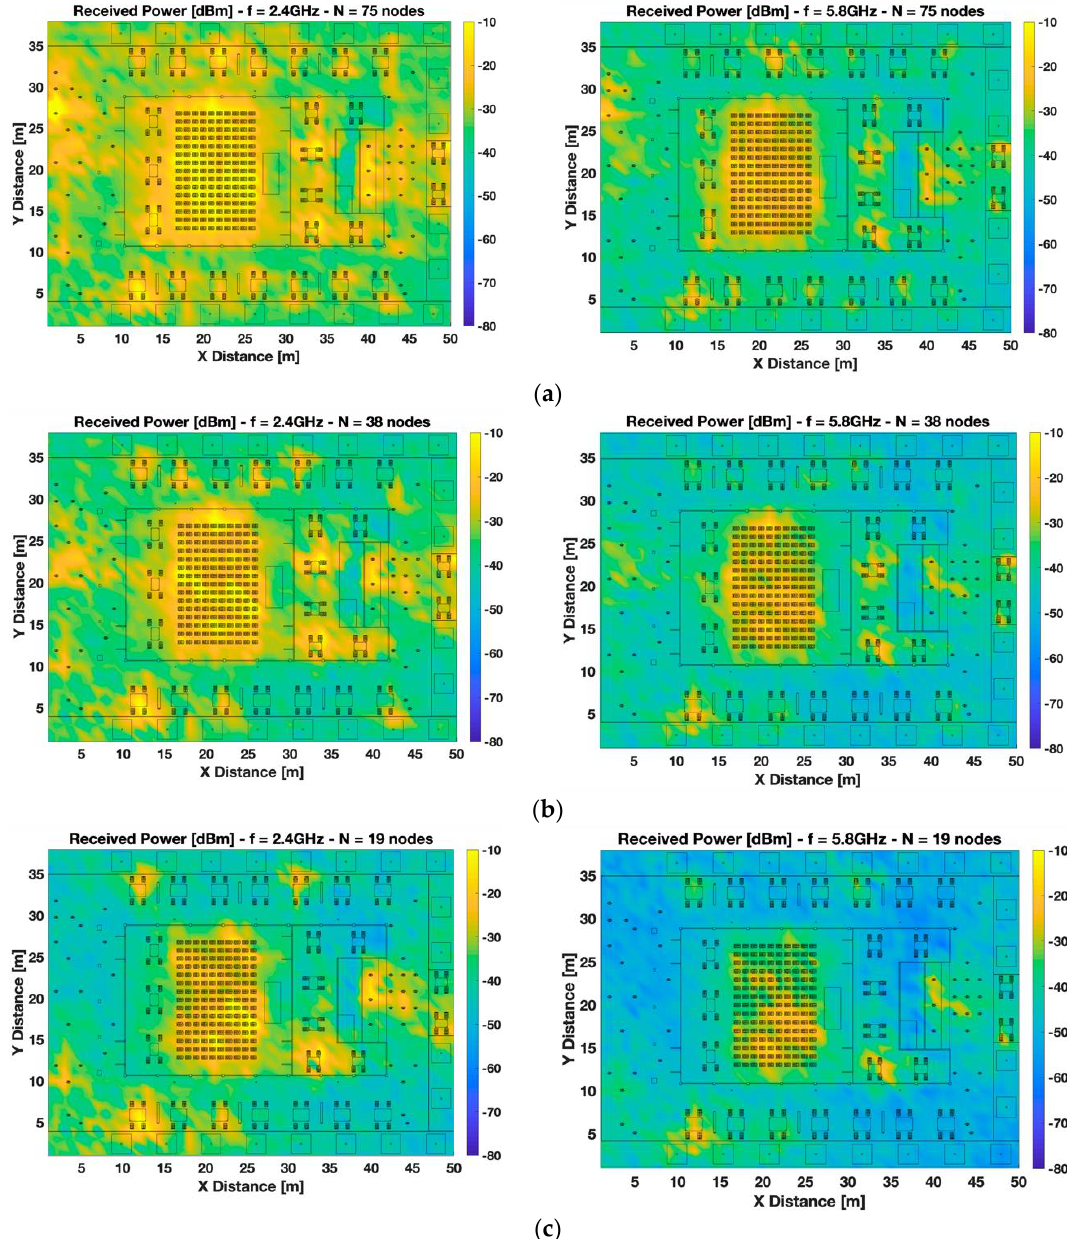
Figure 4. Bi-dimensional planes of received power [dBm] at 0.8 m height at 2.4 GHz and 5.8 GHz frequency bands. Different scenario setups have been considered: ( a ) high-node density scenario, ( b ) medium-node density scenario, and ( c ) low-node density scenario.